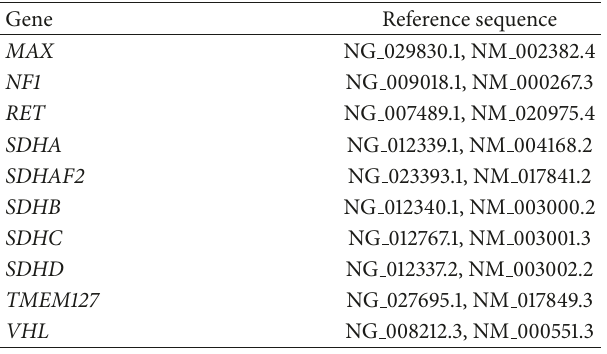
Table 1: Paraganglioma/pheochromocytoma genetic mutational panel screened in the rare disease control program in